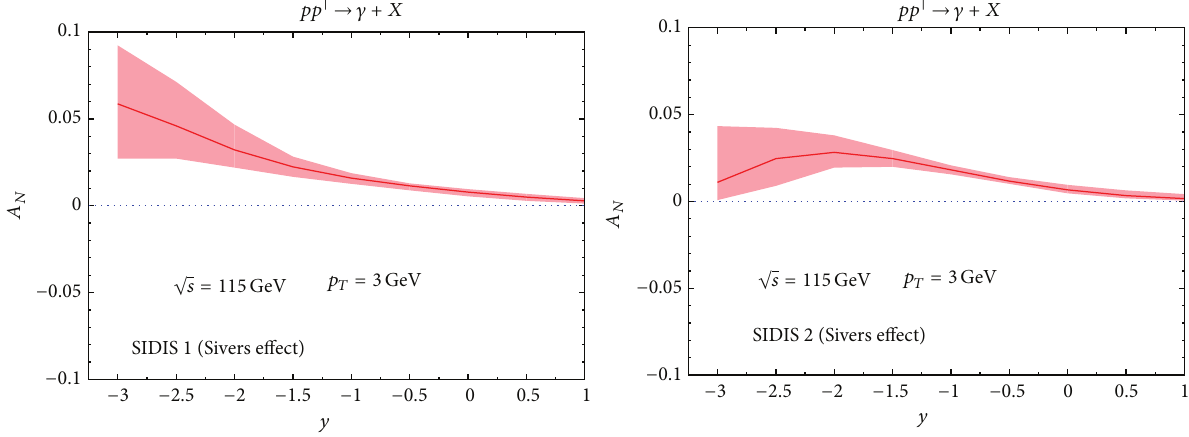
Figure 6: Our theoretical estimates for 𝐴 𝑁 versus 𝑦 at √𝑠 = 115 GeV and 𝑝 𝑇 = 3 GeV, for inclusive photon production in 𝑝𝑝 ↑ → 𝛾𝑋 processes, computed according to (6)–(8) of the text. Only the Sivers effects contributes. The computation is performed adopting the Sivers functions of [20] (SIDIS 1, left panel) and of [21] (SIDIS 2, right panel). The overall statistical uncertainty band, also shown, is the envelope of the two independent statistical uncertainty bands obtained following the procedure described in Appendix A of